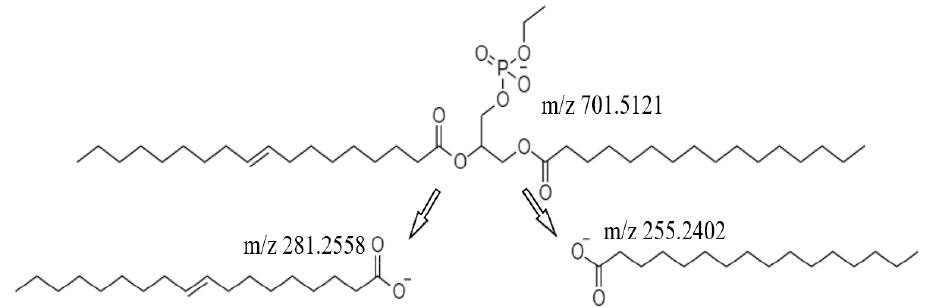
Figure 1. Example of fragmentation pattern for PEth 16:0/18:1.